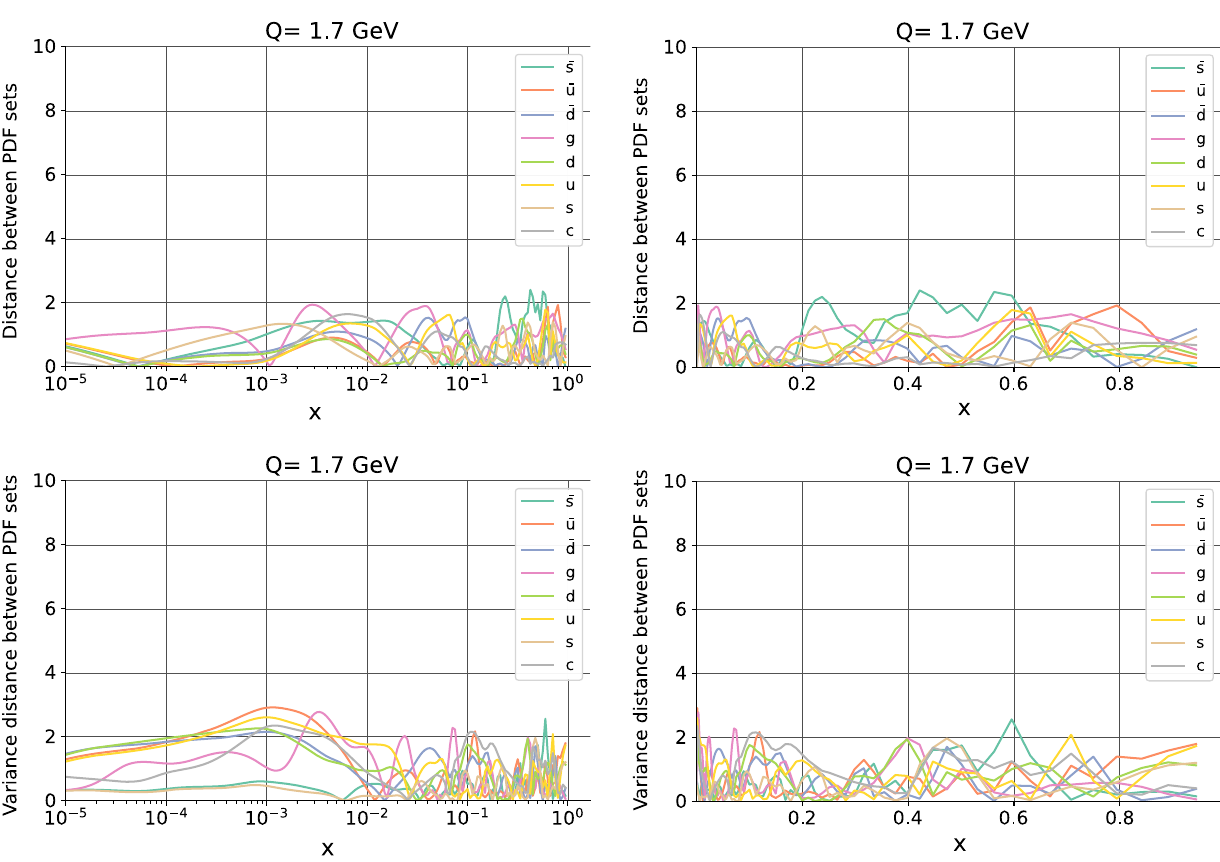
Fig. 3 Distances between central values (top) and uncertainties (bottom) of two PDF sets determined using the NNPDF4.0 methodology. Results are shown both on a logarithmic (left) and linear (right) scale in x